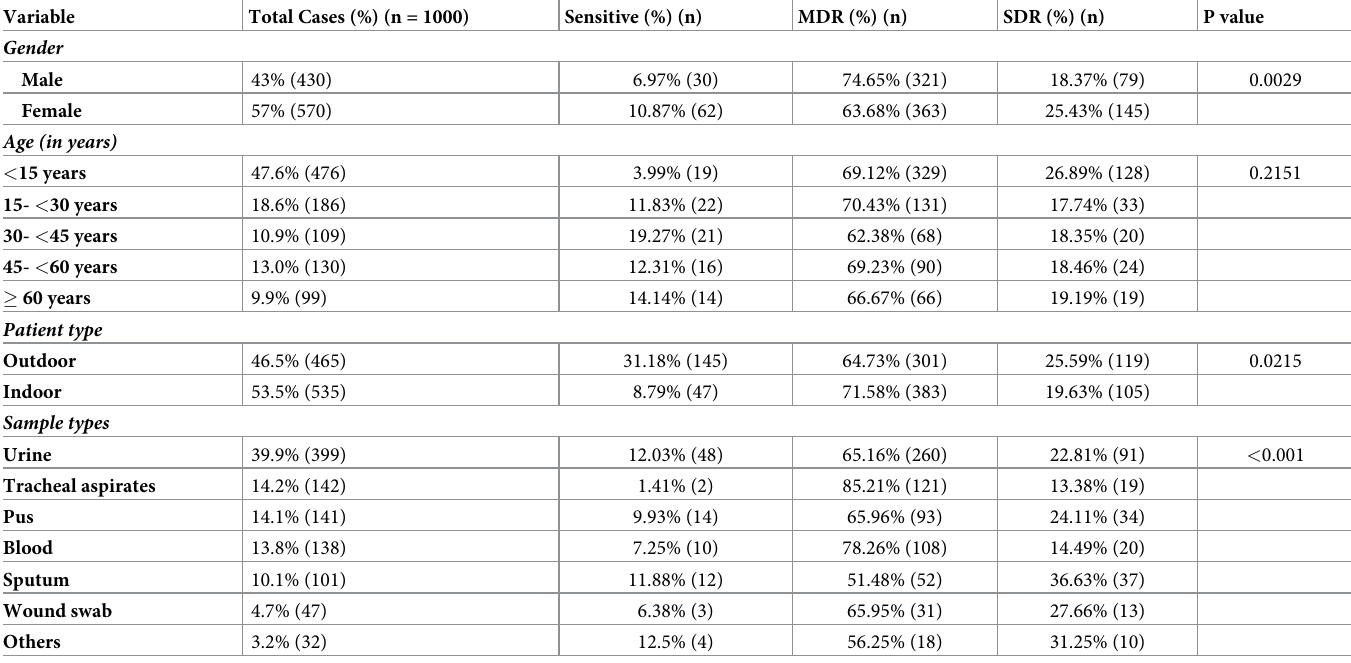
Table 1. Clinical characteristics of study